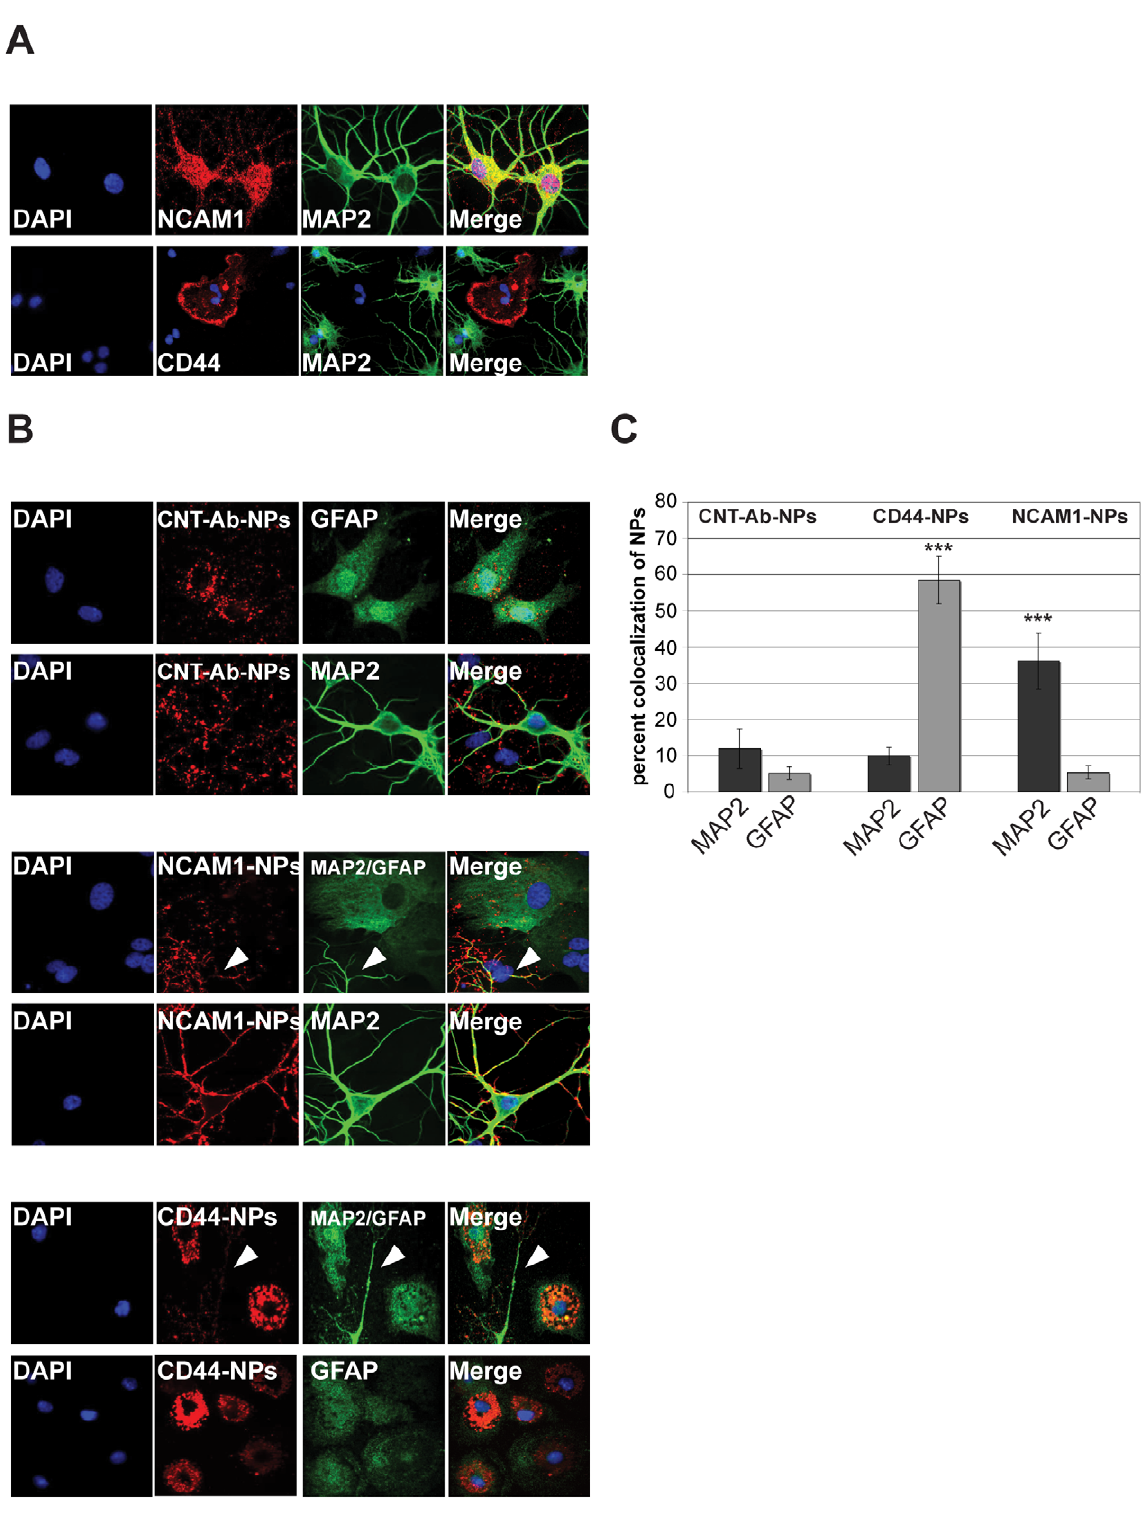
Figure 5. Cell type specific targeting of BBB-NPs. A) Immuncytochemistry of hippocampal neurons 14DIV stained with antibodies against NCAM1, CD44 and MAP2. The neuronal protein NCAM1 is found to label neurons that are also immuno-positive for MAP2 (upper row of images). CD44 positive glia are not labeled with MAP2 (lower panel). B) Fluorescent images of neuronal/glial cultures treated with TMR-labeled NPs (red) coated with antibodies against NCAM1 or CD44. Antibodies against MAP2 and the glial specific intermediate filament associated protein GFAP (green) were used to label neurons and glia in these cultures. Unmodified NPs (CNT-Ab-NPs) association with glial cells as well as neurons (upper panel). NCAM1-NPs preferentially label MAP2 positive neurons (arrow, middle panel) but not GFAP positive glia. In contrast, CD44-NPs preferentially label glial cells and a reduced labeling of neurons (arrow, lower panel) is seen. Note that the anti-CD44 ligand appears to promote NPs endocytosis. C)